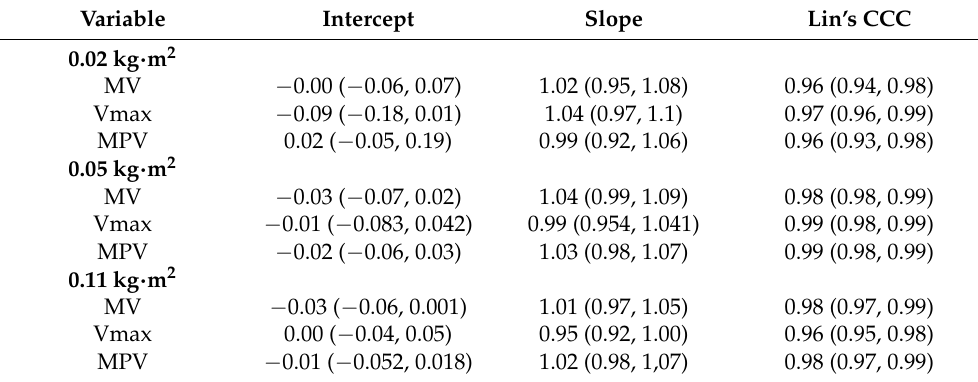
Table 2. Validity test results by ordinary least products (OLP) regression (Intercept, Slope) and Lin’s concordance correlation coefficient (CCC) with 95% confidence interval (min, max) for mean concentric velocity (MV), maximum velocity (Vmax) and mean propulsive velocity (MPV) at